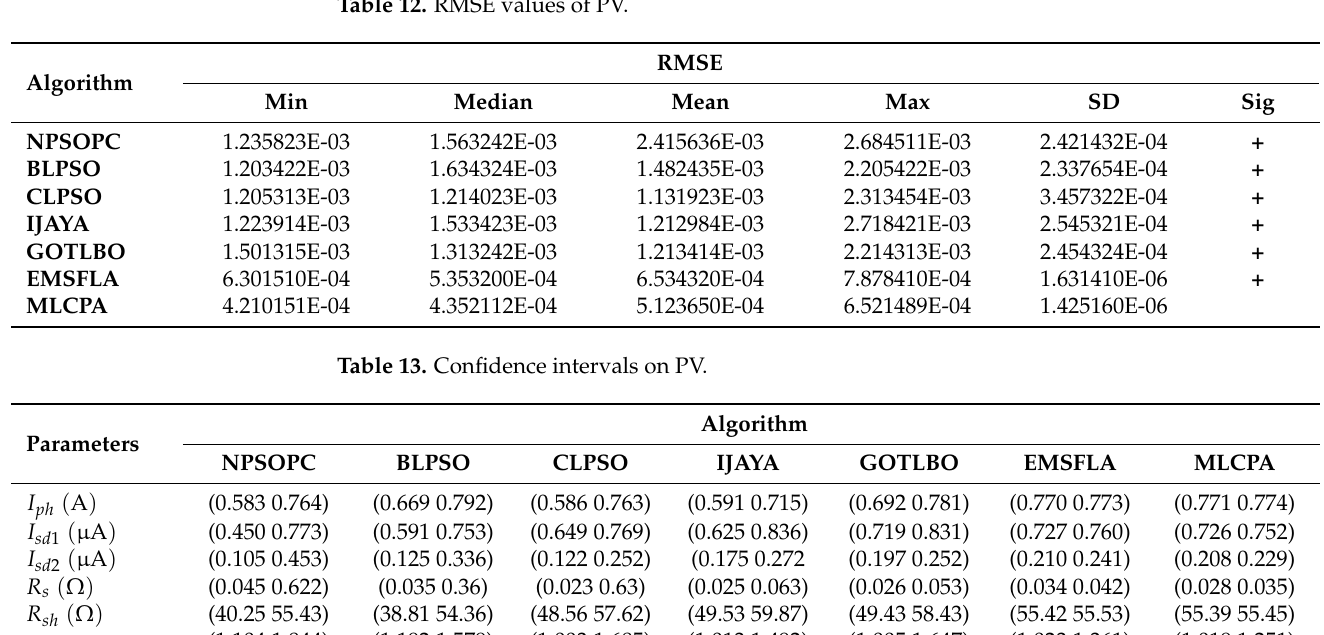
Table 12. RMSE values of PV.